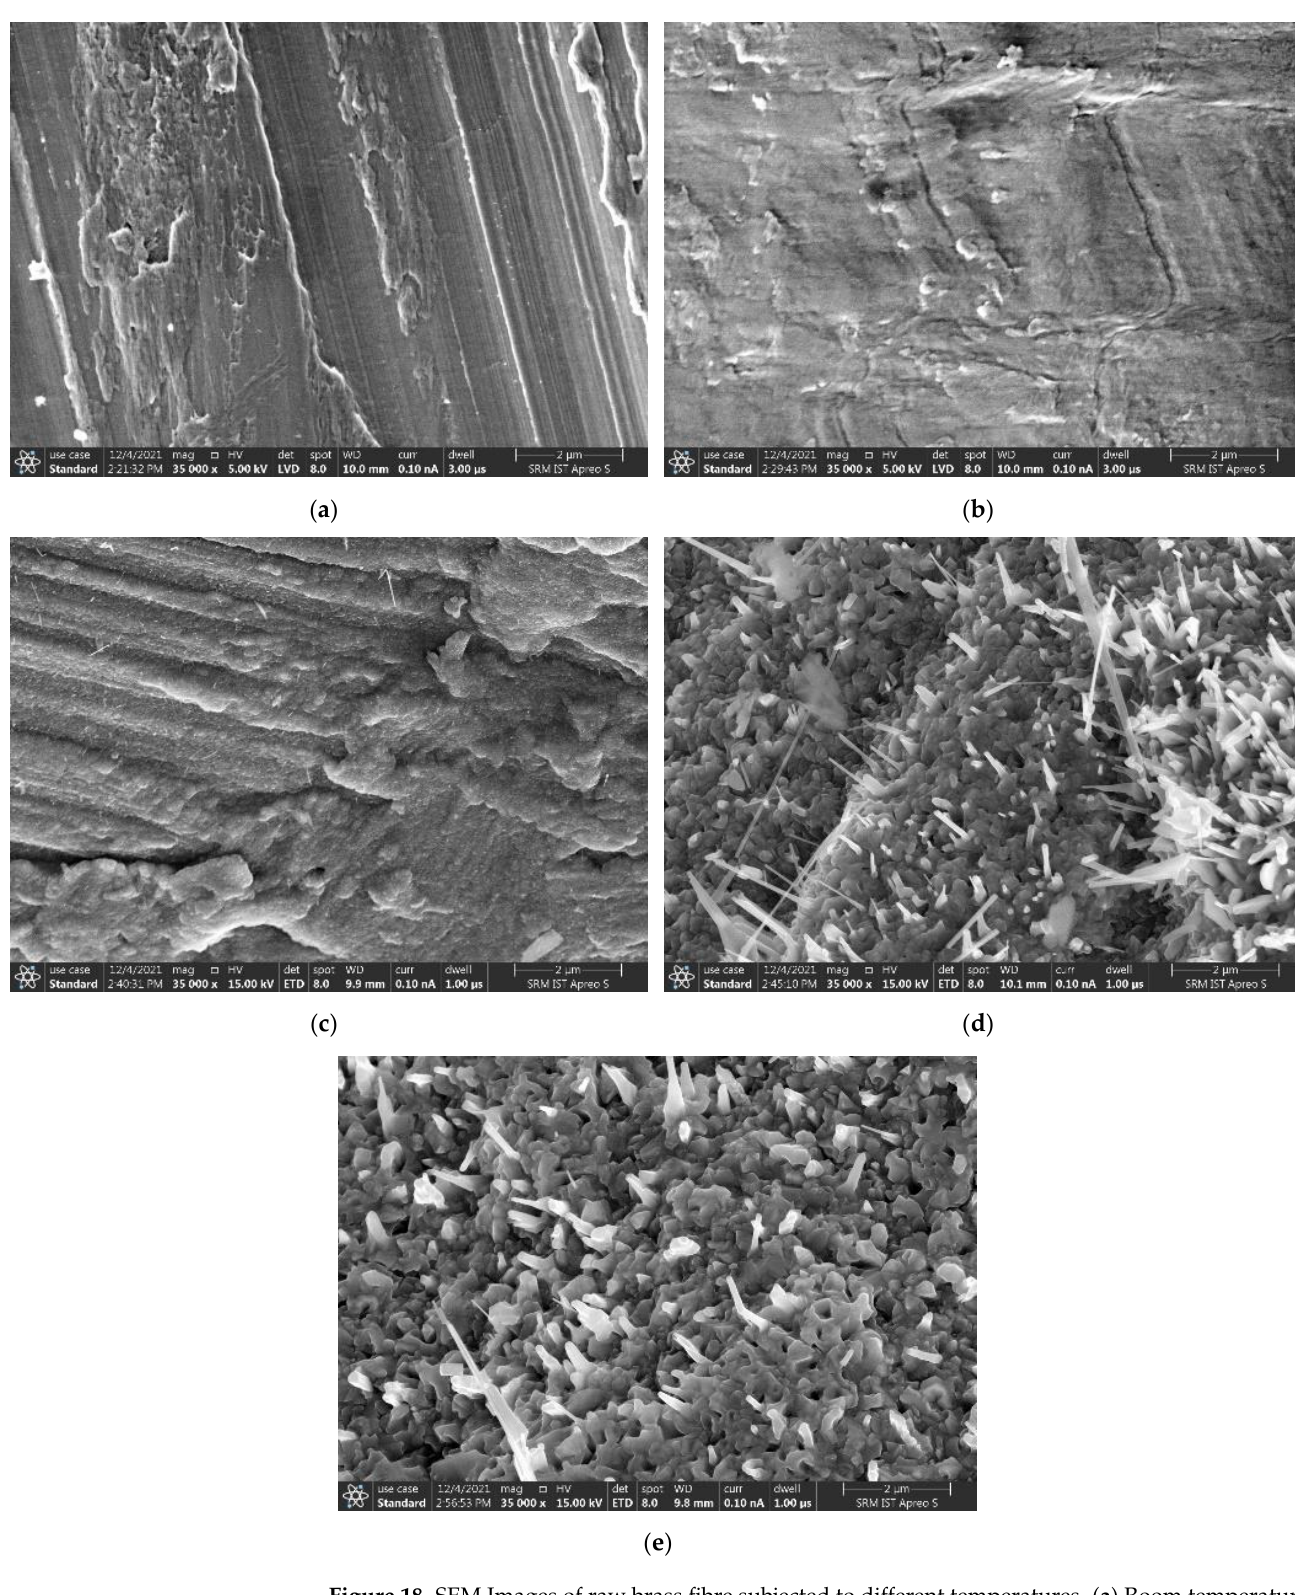
Figure 18. SEM Images of raw brass fibre subjected to different temperatures. ( a ) Room temperature;